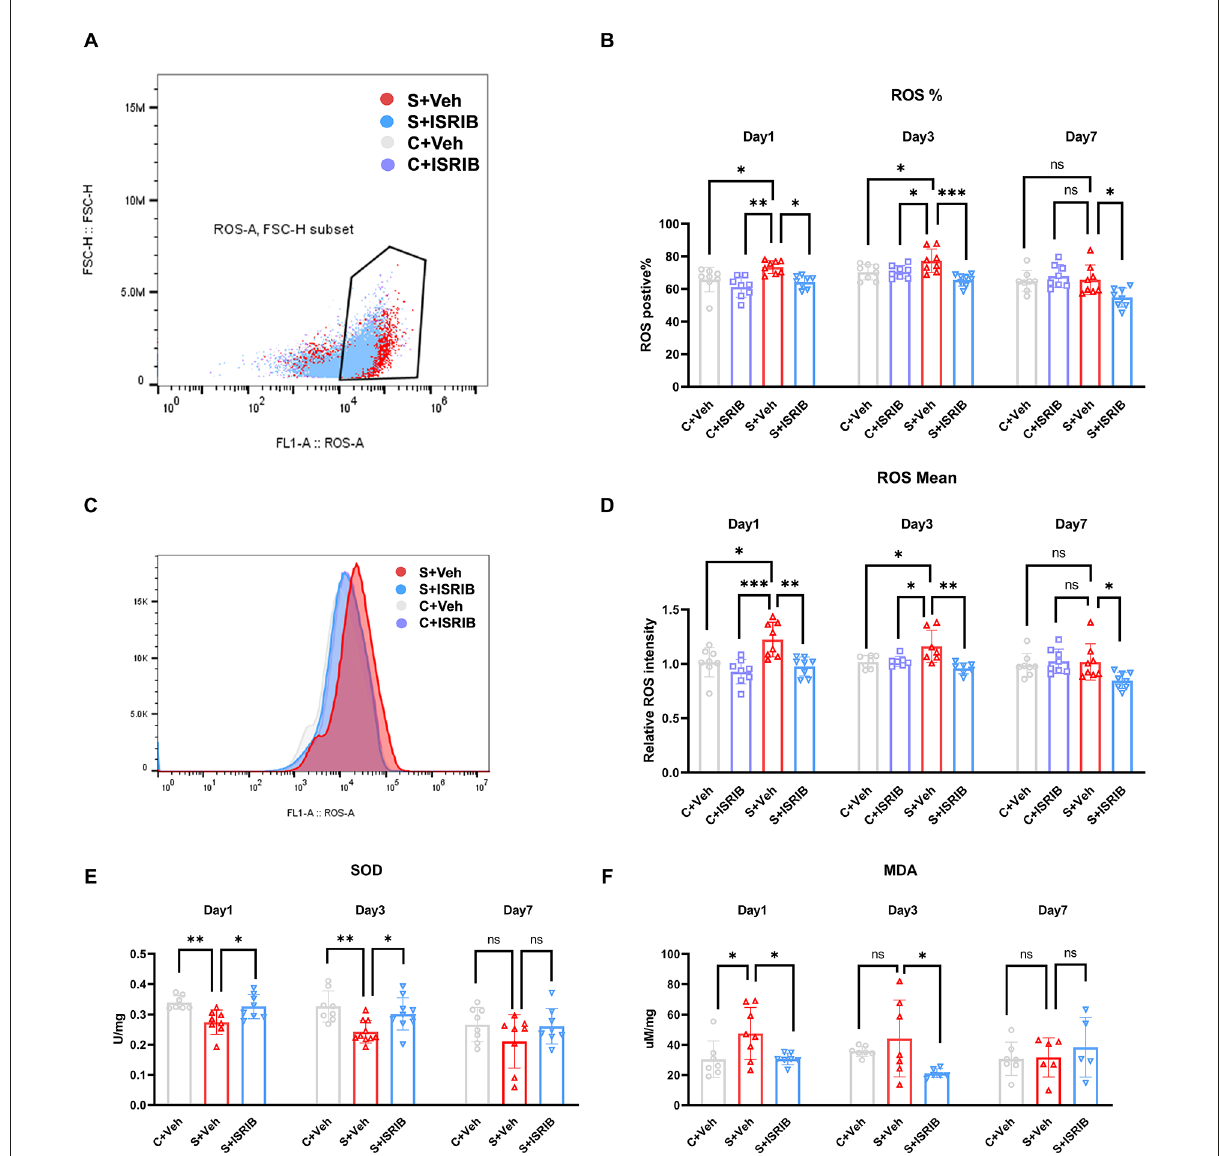
FIGURE3 POCD induced oxidative stress in the hippocampus of mice and therapy with ISRIB attenuates the oxidative stress. (A) Representative ROS positive cell in flow cytometry. (B) The change in ROS-positive cells in the hippocampus of mice post-surgery days 1, 3, and 7 in all groups. (C) Representative ROS fluorescence intensity in flow cytometry. (D) The change in relative ROS fluorescence intensity in the hippocampus of mice post-surgery days 1, 3, and 7 in all groups. (E) The change in SOD levels in the hippocampus of mice post-surgery days 1, 3, and 7 in all groups. (F) The change in MDA levels in the hippocampus of mice post-surgery days 1, 3, and 7 in all groups. Data are presented as the mean ± SEM. One-way ANOVA was used for statistical analysis. ∗ p < 0.05; ∗∗ p < 0.01; ∗∗∗ p < 0.001; ns: no statistical